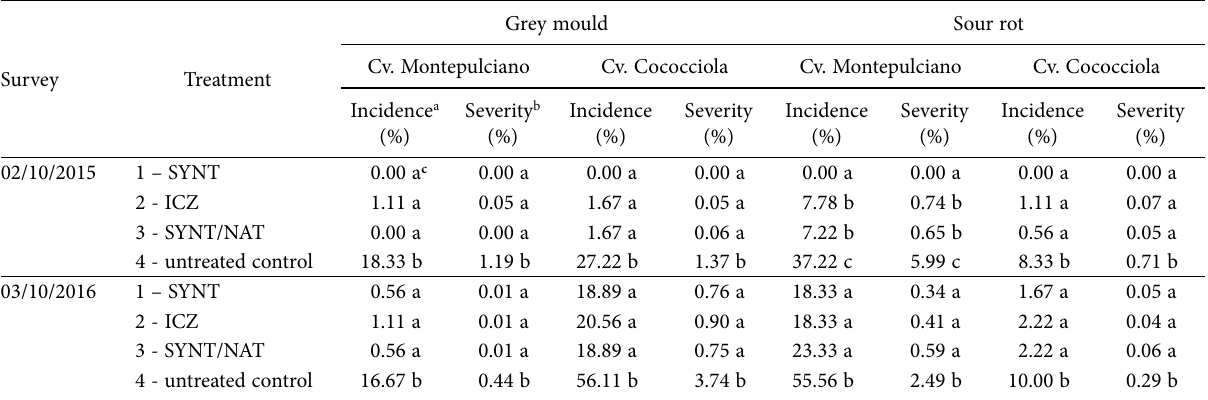
a Incidence = percentage of infected bunches on the total number of bunches. b Severity = percentage of infected berries on the total number of berries. c Statistical analyses were performed according to Tukey’s honest significant difference (HSD) test. Different letters indicate significant differences ( P =